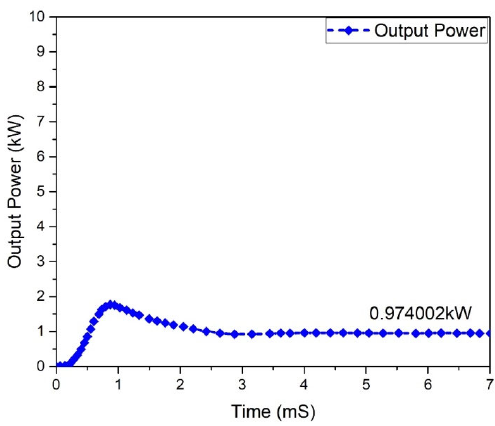
Figure 28. Output power (GaN ‐ HEMT).